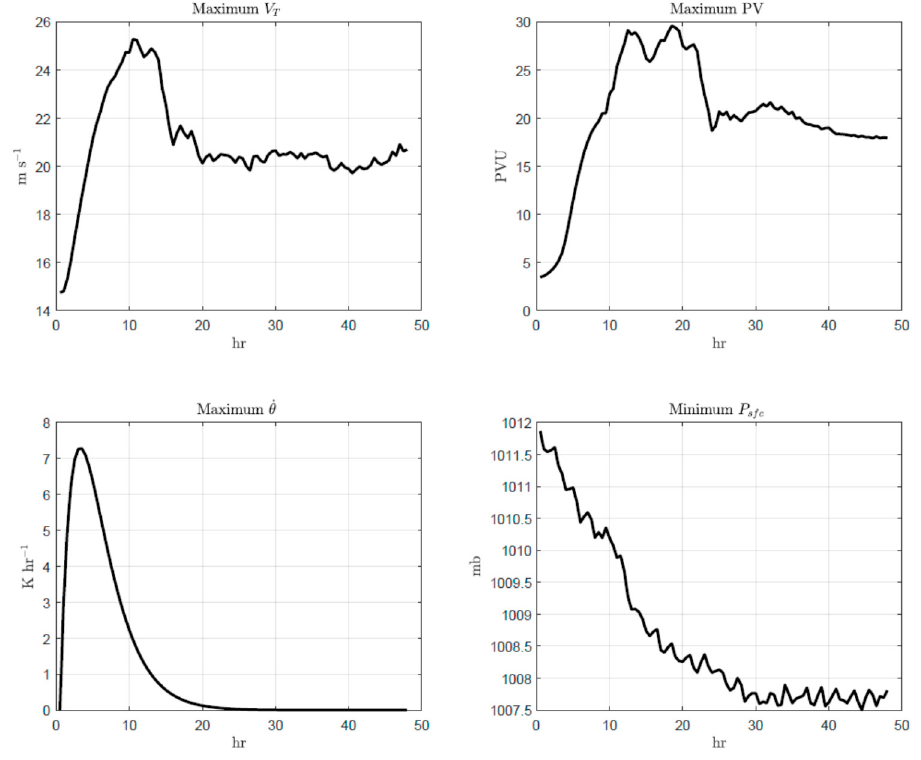
Figure 6. The time evolution of the maximum azimuthal velocity ( upper left panel ), maximum PV ( upper right panel ), maximum diabatic heating rate ( lower left panel ), and minimum central pressure ( lower right panel ) from (cid:1872) = 0 to (cid:1872) = 48